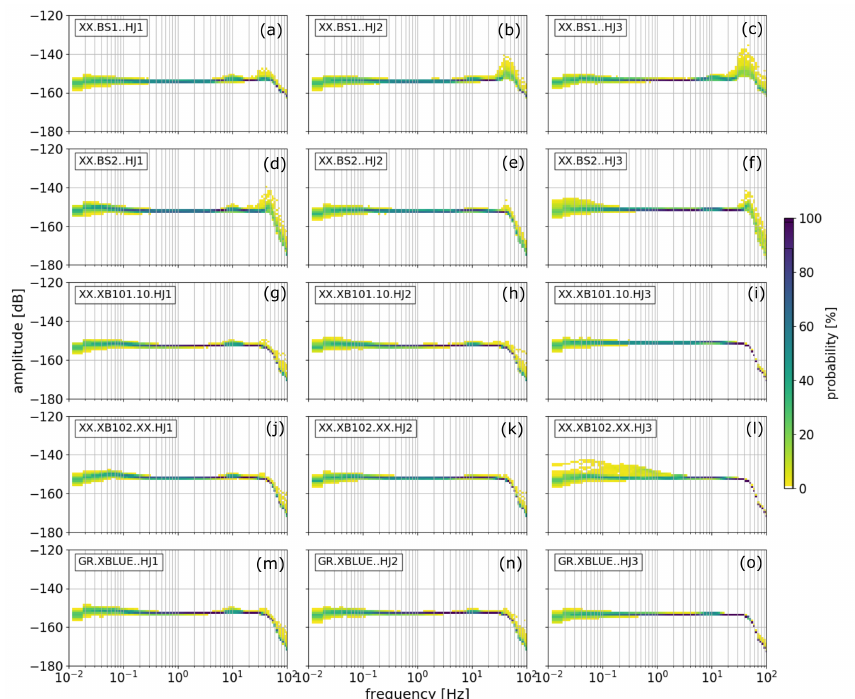
Figure 2. Probabilistic power spectral densities for all three components of all five rotational sensors for 29 August, Thursday. Components HJ1 ( a , d , g , j , m ) and HJ2 ( b , e , h , k , n ) correspond to the East and North component while component HJ3 ( c , f , i , l , o ) corresponds to the vertical component, respectively.